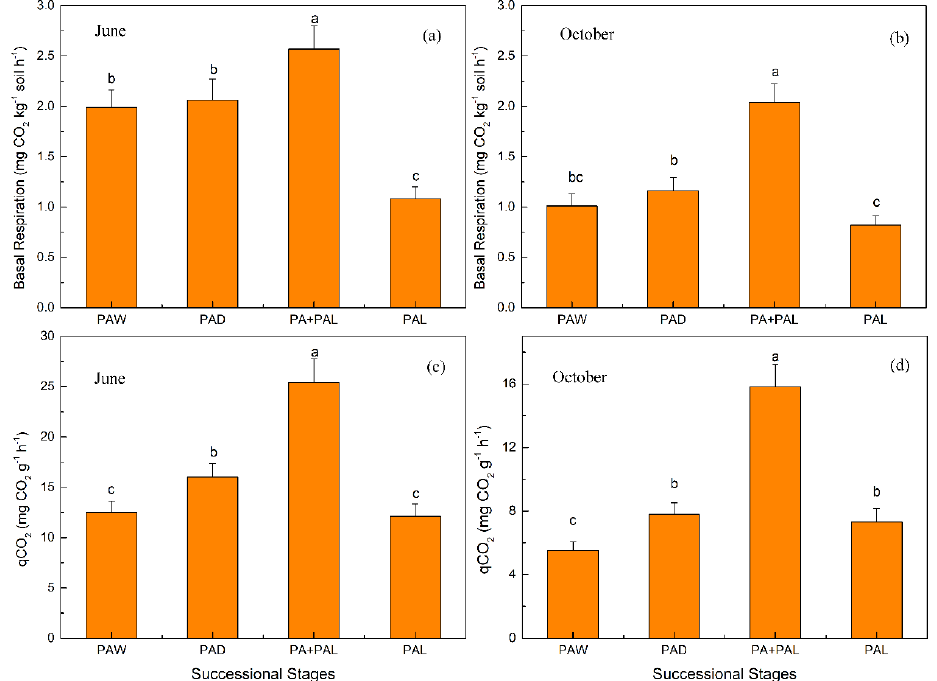
Figure 4. Soil basal respiration and microbial metabolic quotient (qCO 2 ) under different successional stages in June ( a , c ) and October ( b , d ). Values are Mean ± SE ( n = 9). Different letters over the bars indicate statistically significant differences between different stages. TAW, T. augustifolia wetland; PAW, P. australis wetland; PAD, P. australis dry land; PA+PAL, mixed grassland with P. australis and P. arundinacea L.; PAL, P. arundinacea L. grassland.